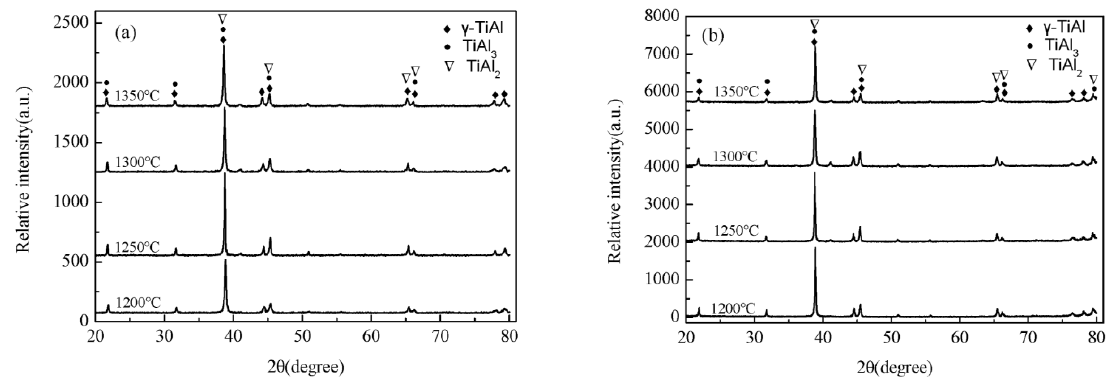
Figure 11. ( a ) XRD patterns of Ti-48Al-2Cr-8Nb alloys produced by SPS at different